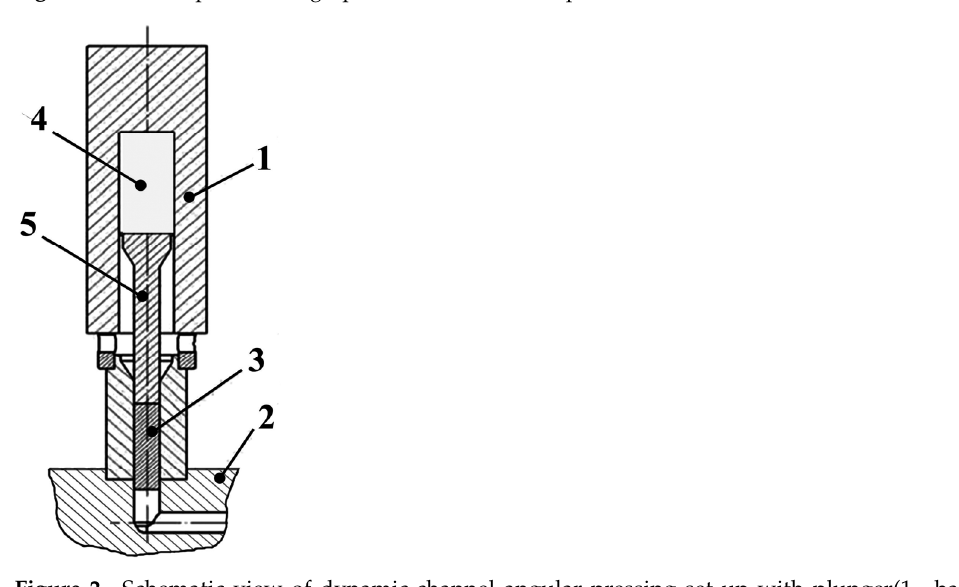
Figure 1. Raman spectrum of graphene in AlMnGr composite.